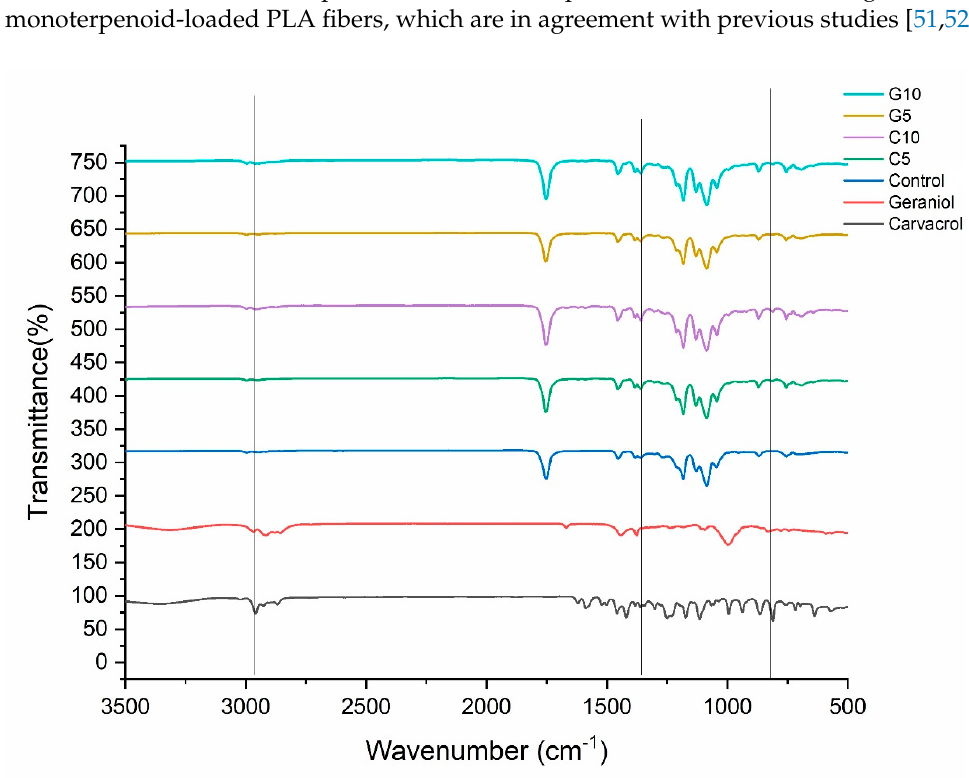
Figure 4. FT ‐ IR profiles of neat PLA nanofibers (control), C5, C10, carvacrol, G5, G10, and